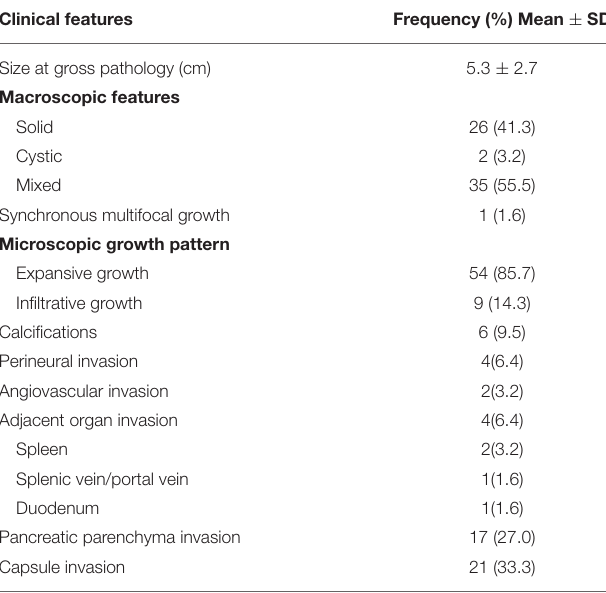
TABLE 1 | Demographic characteristics of 63 patients with SPN. Clinical Features